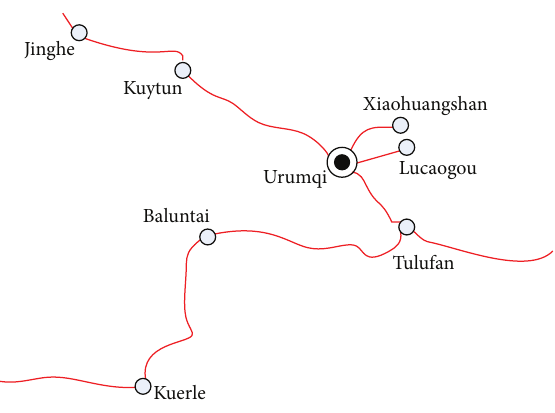
Figure 1: Actual Railway